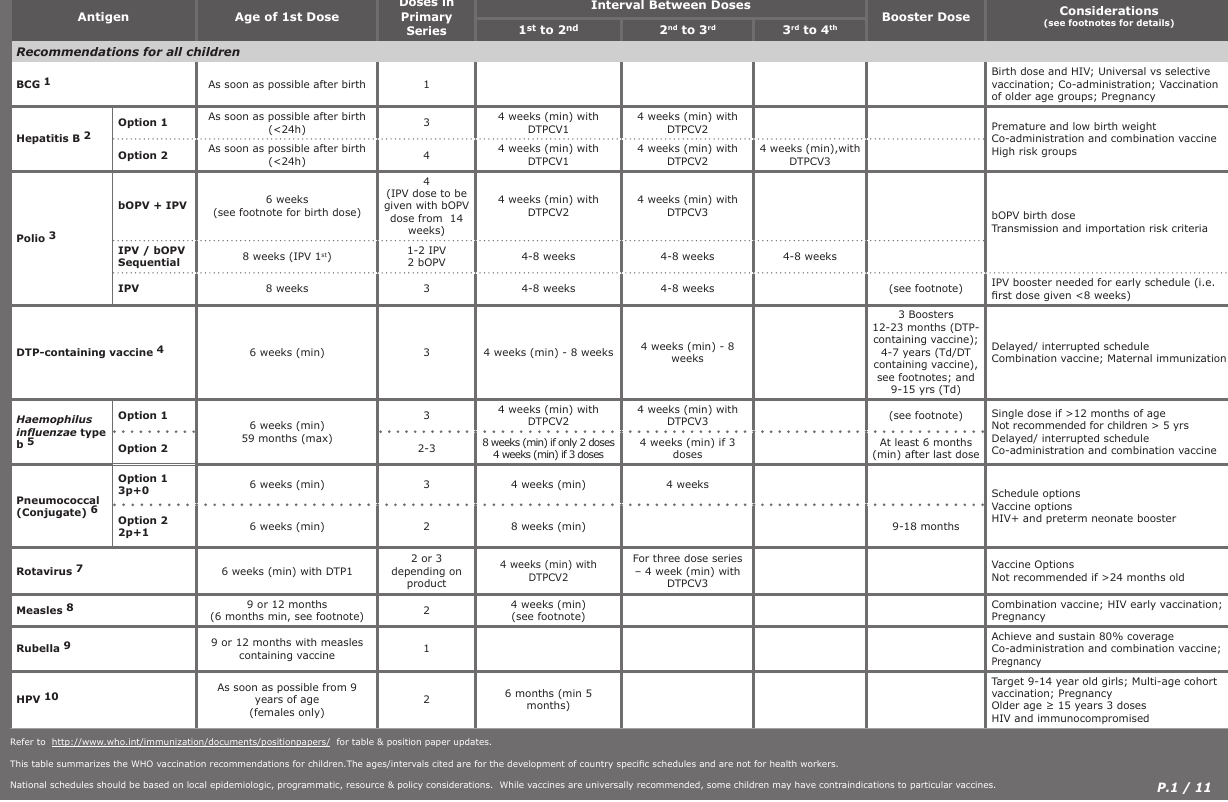
Table 2: Summary of WHO Position Papers - Recommended Routine Immunizations for Children